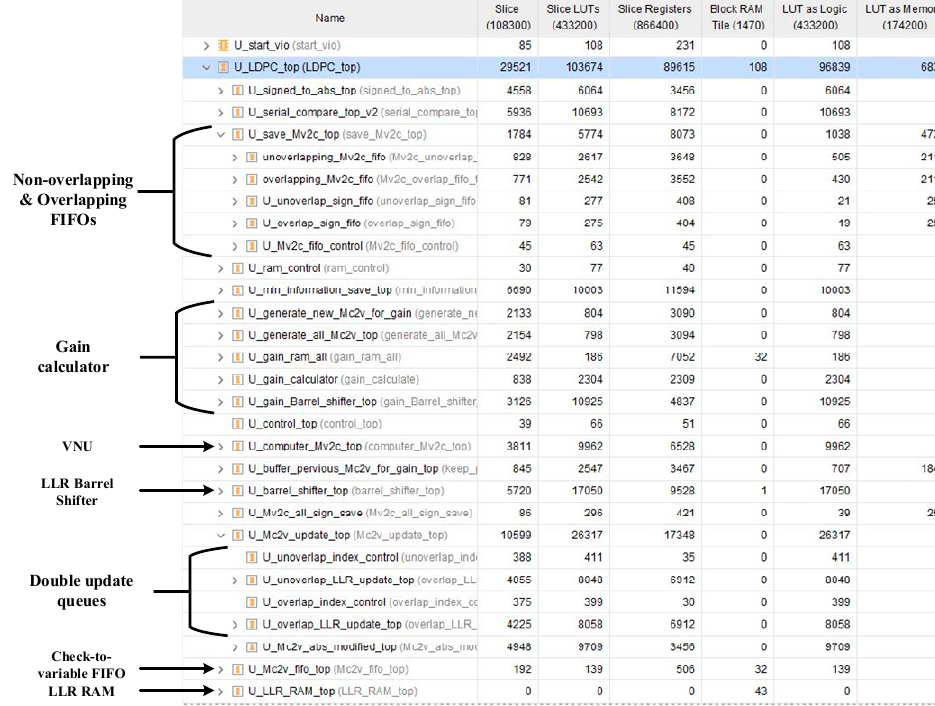
Figure 9. The resource usage of every module in the hardware implementation of priority-based decoder with double update queues.